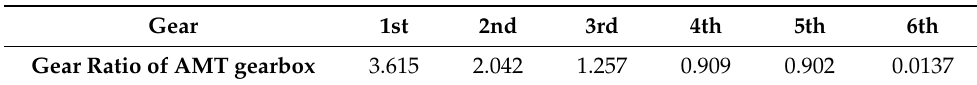
Table 6. Gear ratio of AMT gearbox.